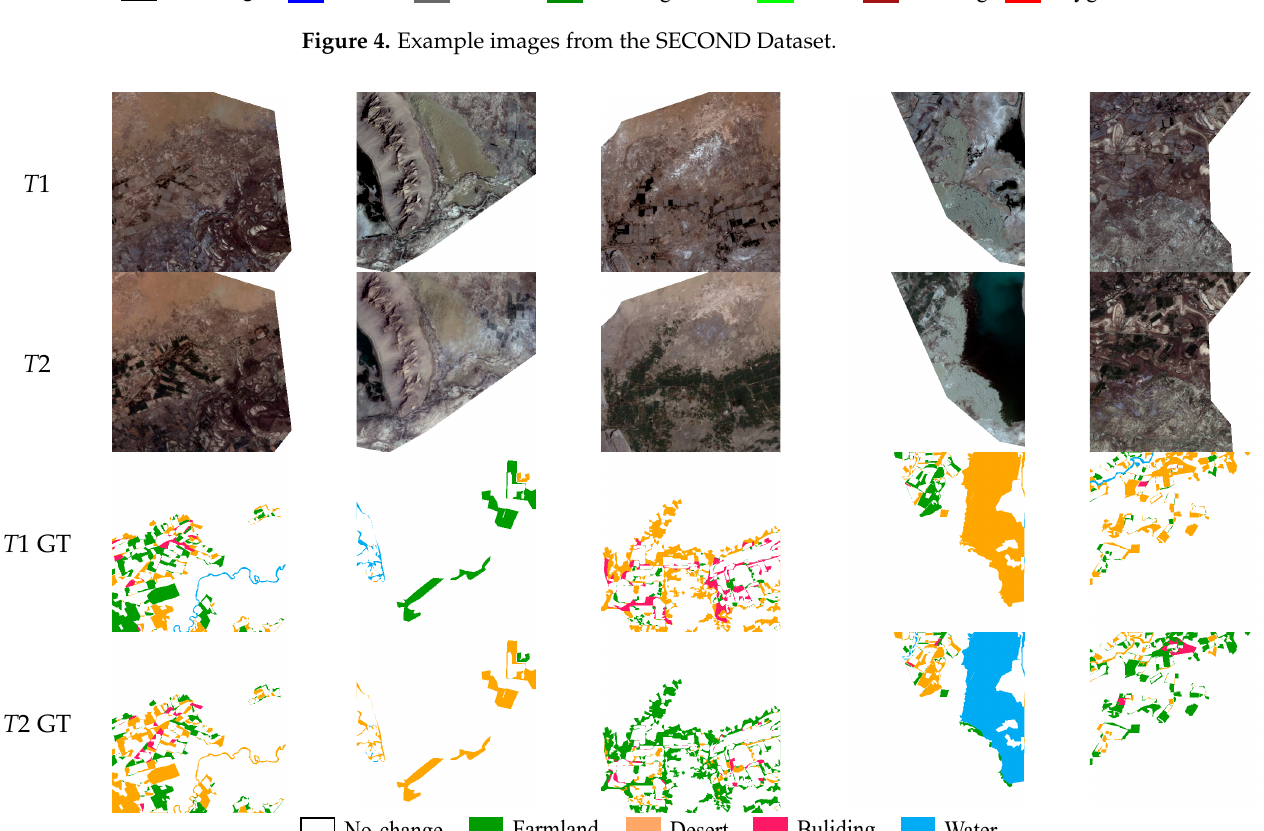
Figure 5. Example images from the Landsat-SCD Dataset.